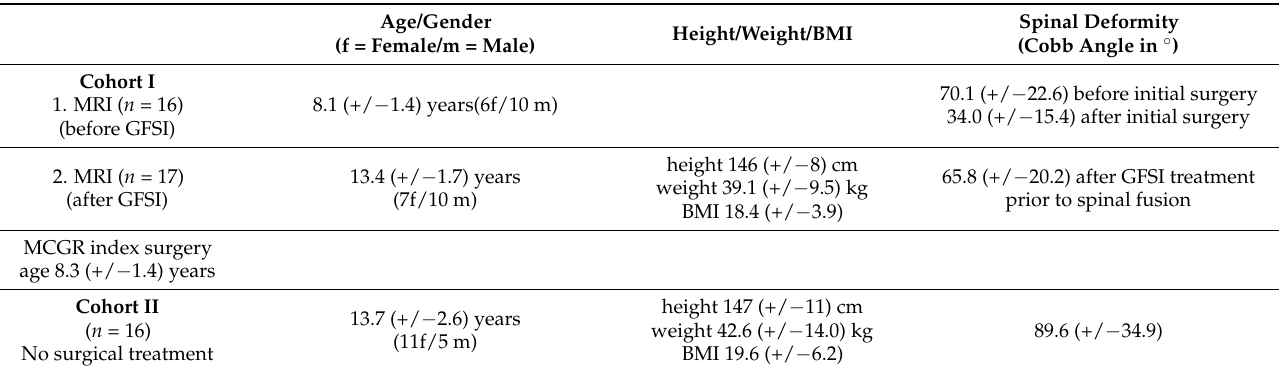
Table 1. Patient